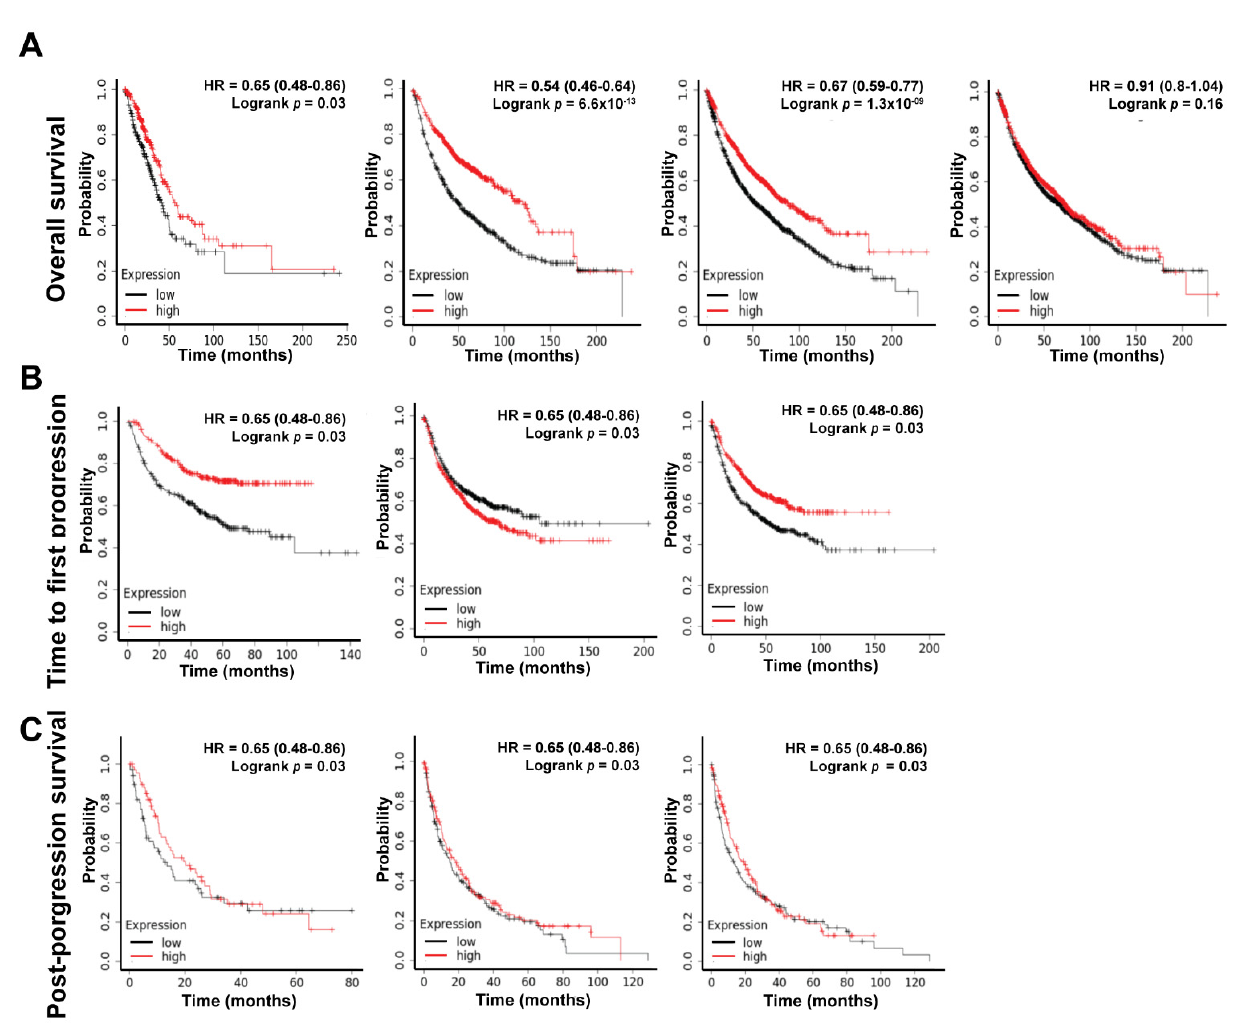
Figure 2. Patients with lower expression levels of ADAMTS8 survive for a shorter duration in lung adenocarcinoma. ADAMTS8 had low expression in tumor parts, and survival analyses were performed to confirm whether ADAMTS8 plays a significant clinical role. The KM plotter revealed that the lower expression of ADAMTS8 conferred lower overall survival ( A ) and shorter time for first progression ( B ) but not post-progression survival ( C ). Abb.: OS, overall survival; FP, time to the first progression; PPS, post-progression survival.